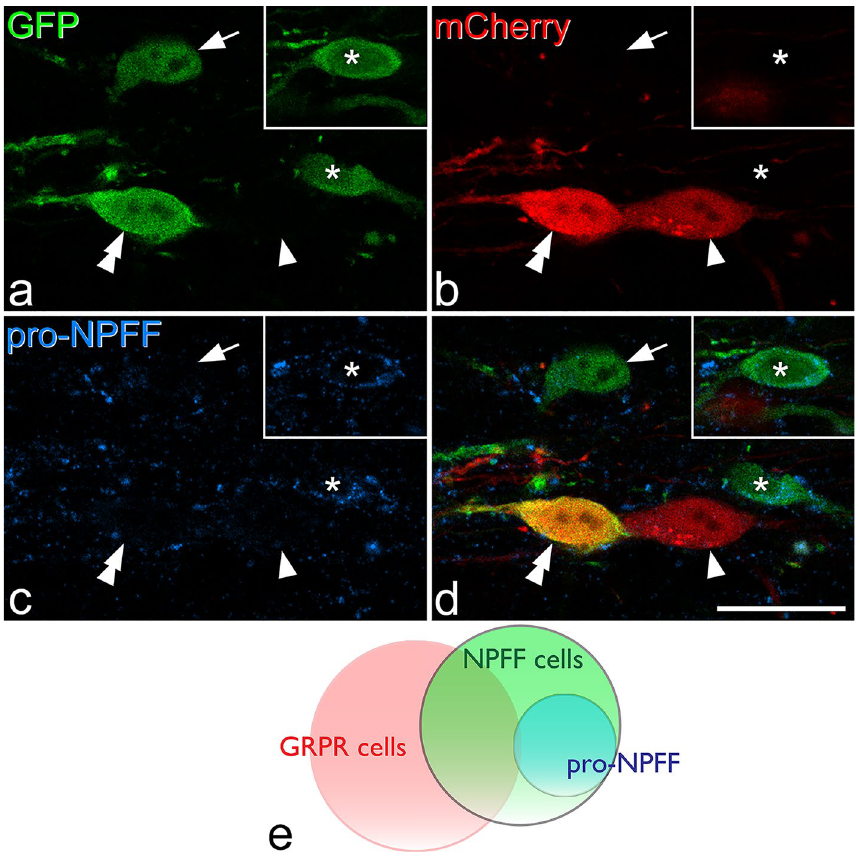
Figure 7. Immunostaining for pro-NPFF in a section obtained from a NPFF Cre ;GRPR Flp mouse that had been injected with AAVs coding for Cre-dependent GFP and Flp-dependent mCherry. ( a – c ) show staining for GFP (green), mCherry (red) and pro-NPFF (blue) in a single confocal optical section, while ( d ) shows a merged image. The arrow and asterisk mark cells that are positive for GFP and negative for mCherry. The cell indicated with the asterisk contains pro-NPFF, and this is seen more clearly in a different optical section (inset). The cell marked with the arrow lacks pro-NPFF. The cells indicated with single and double arrowheads are both positive for mCherry. One of them (double arrowheads) is also labelled with GFP, while the other (single arrowhead) is not. Both of these cells lack pro-NPFF-immunoreactivity. ( e ) Venn diagram showing the relationship between cells labelled with each fluorescent protein and pro-NPFF immunoreactivity. pro-NPFF was present in 0.4% of GRPR cells (labelled with mCherry), 25% of NPFF cells (labelled with GFP) and 42% of the cells that were GFP- positive/mCherry-negative. Scale bar = 20